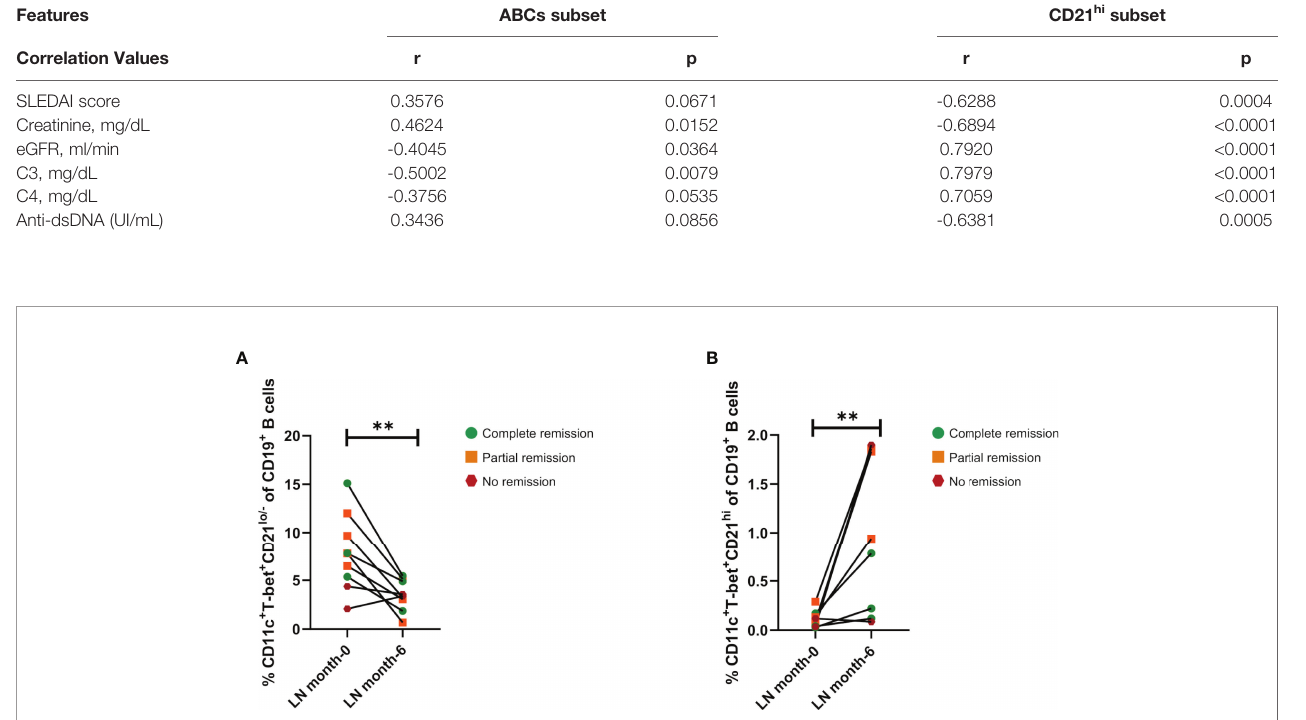
FIGURE 3 | Effect of induction therapy over frequencies of ABCs and CD21 hi subsets. (A) Comparative analysis of ABCs frequencies (relative to CD19 + B cells) between patients at the beginning of induction therapy (month 0), and the same patients after 6 months of treatment (n=9). (B) Comparative analysis of CD21 hi cell frequencies between patients at the beginning of induction therapy and the same patients after 6 months of treatment (n=9). Both comparative analyses were assessed by a Wilcoxon test. **p ≤